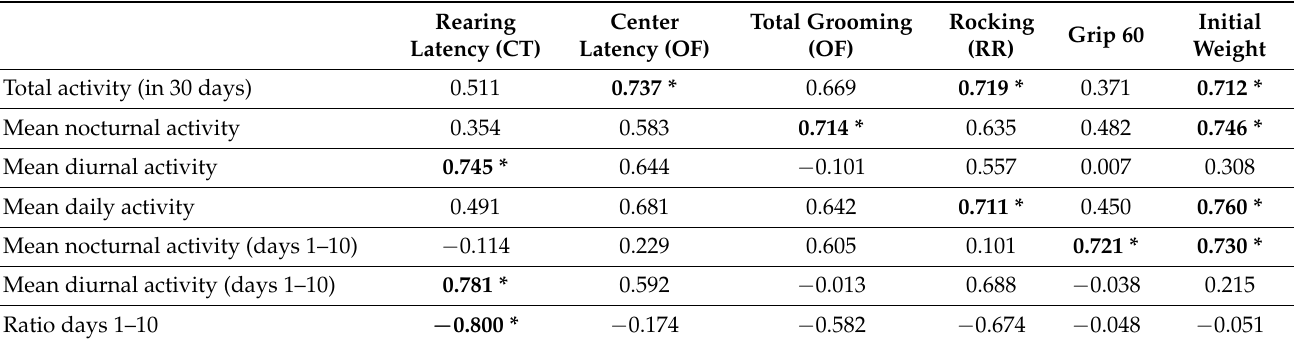
Table 2. Significant correlations in VWR group ( n = 8